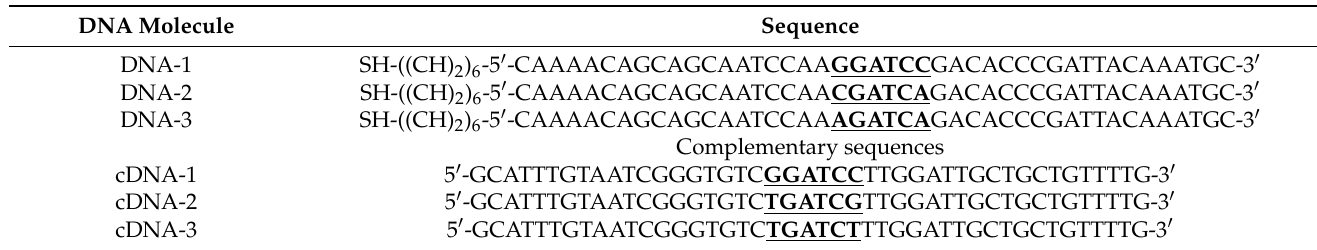
Table 1. DNA sequences and chemical modifications used in this